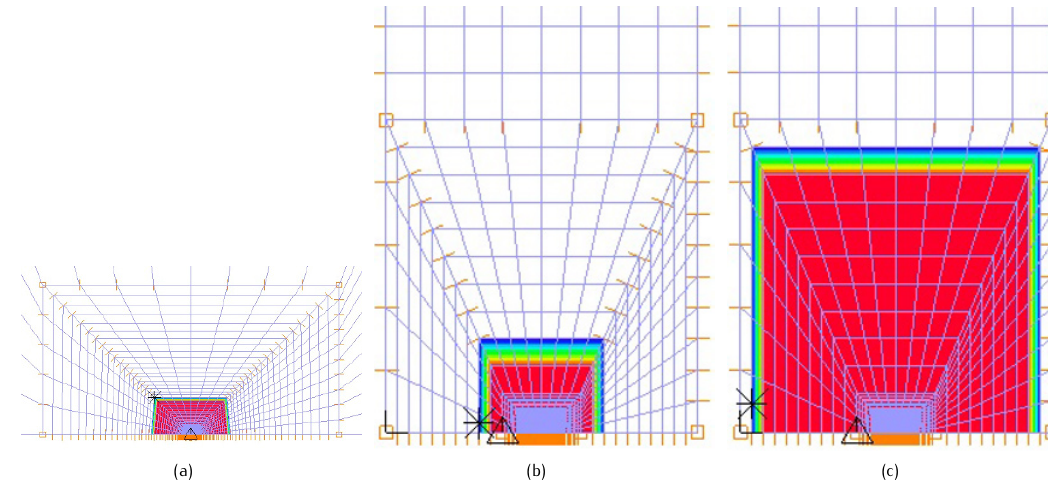
Figure 8. The three integration contours, which were used to calculation the J -integral